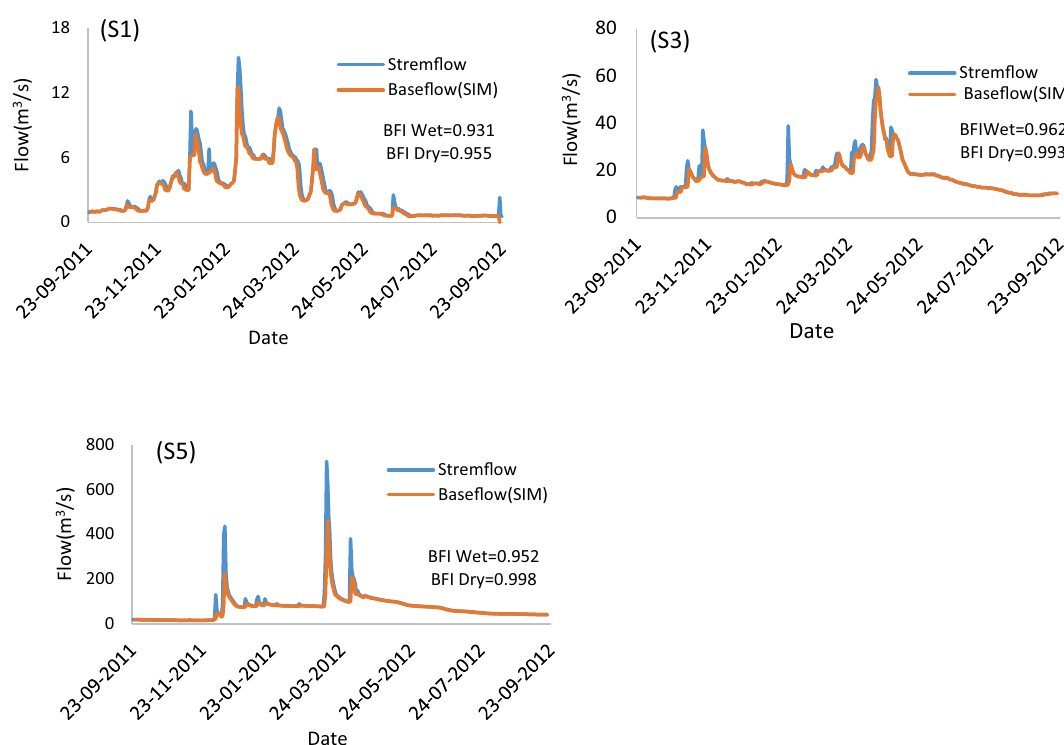
Figure 3. Example of the hydrograph separation results for sub-basins S1, S3, and S5 of the Dez River.